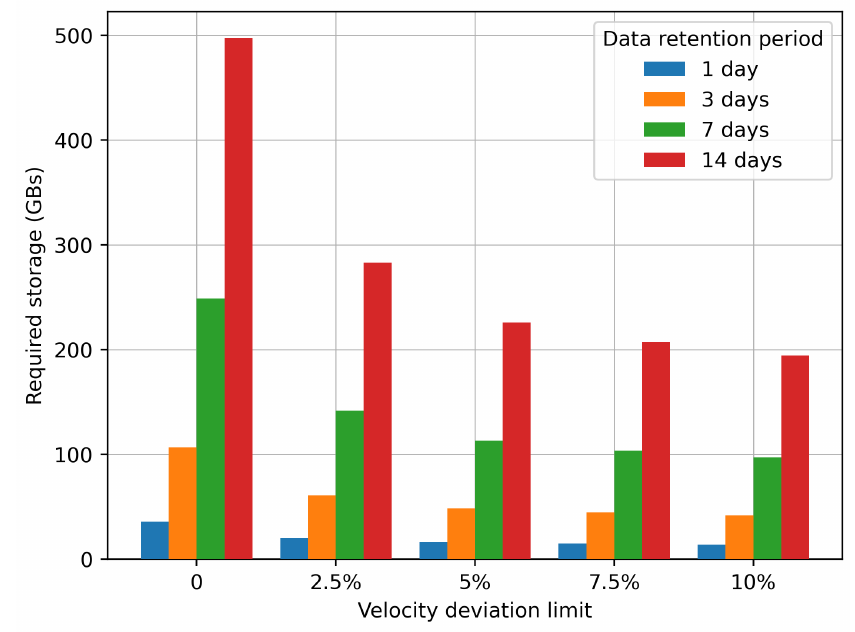
Figure 15. Data storage